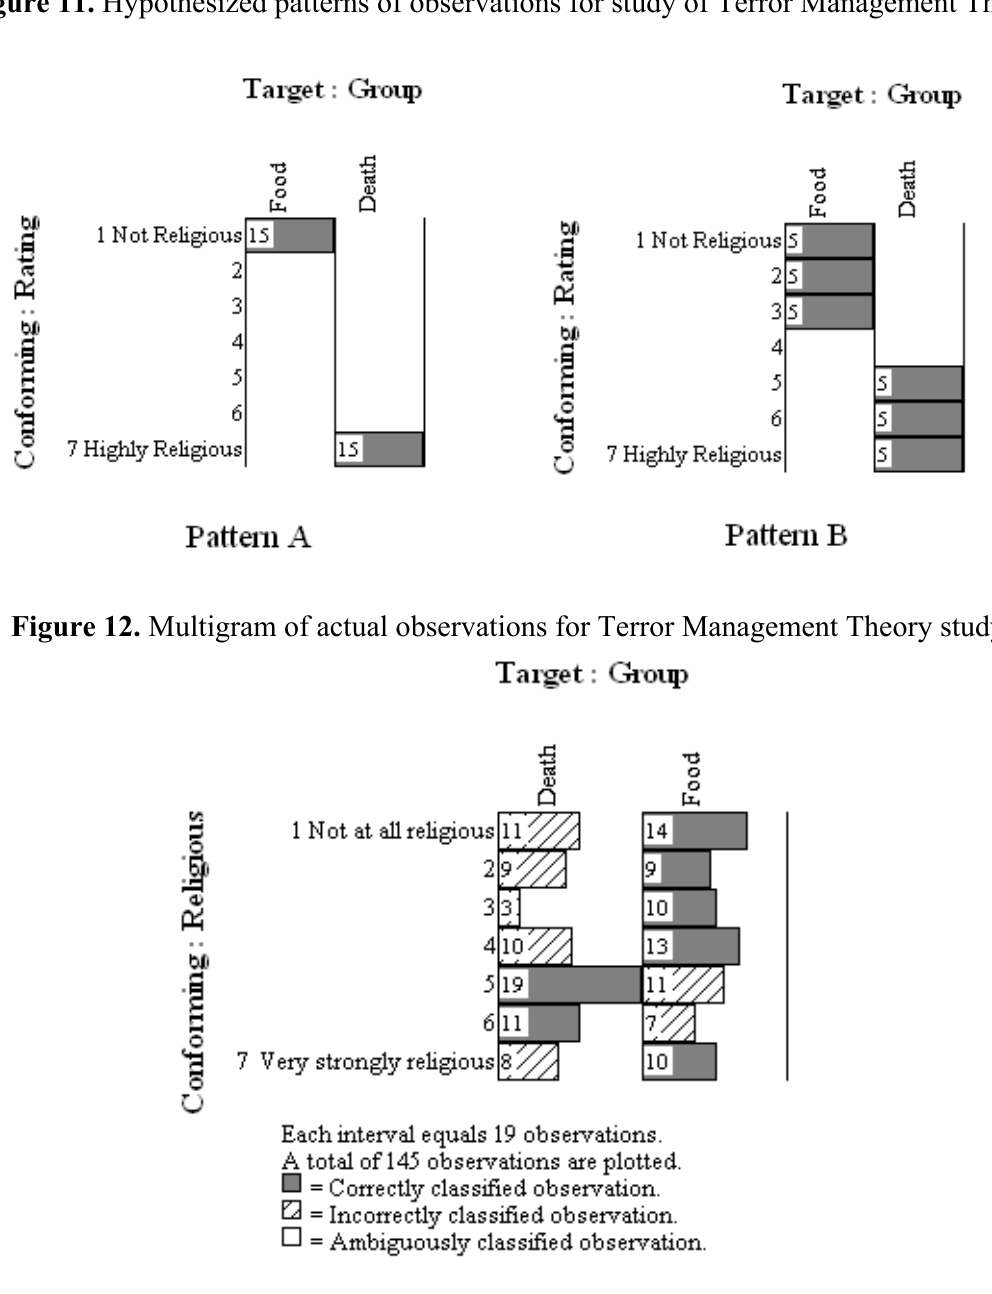
Figure 11. Hypothesized patterns of observations for study of Terror Management Theory.